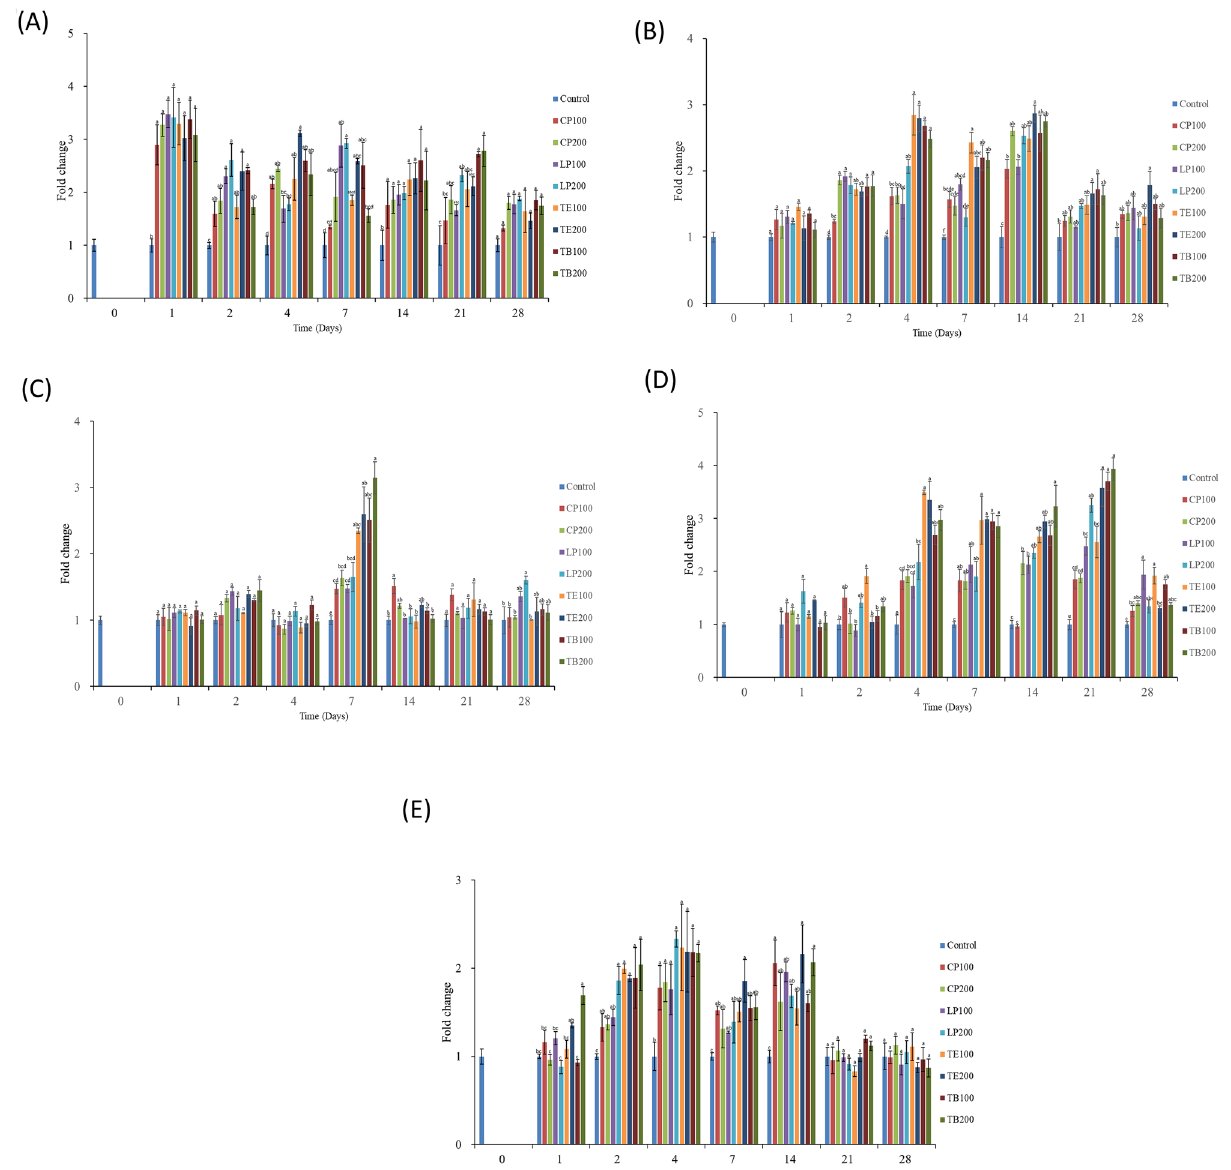
performed to compare the differences between groups at indicated time point. Significant differences ( p < 0.05) between groups are indicated by different letters above bars. The data are expressed as mean ± standard deviation (n =